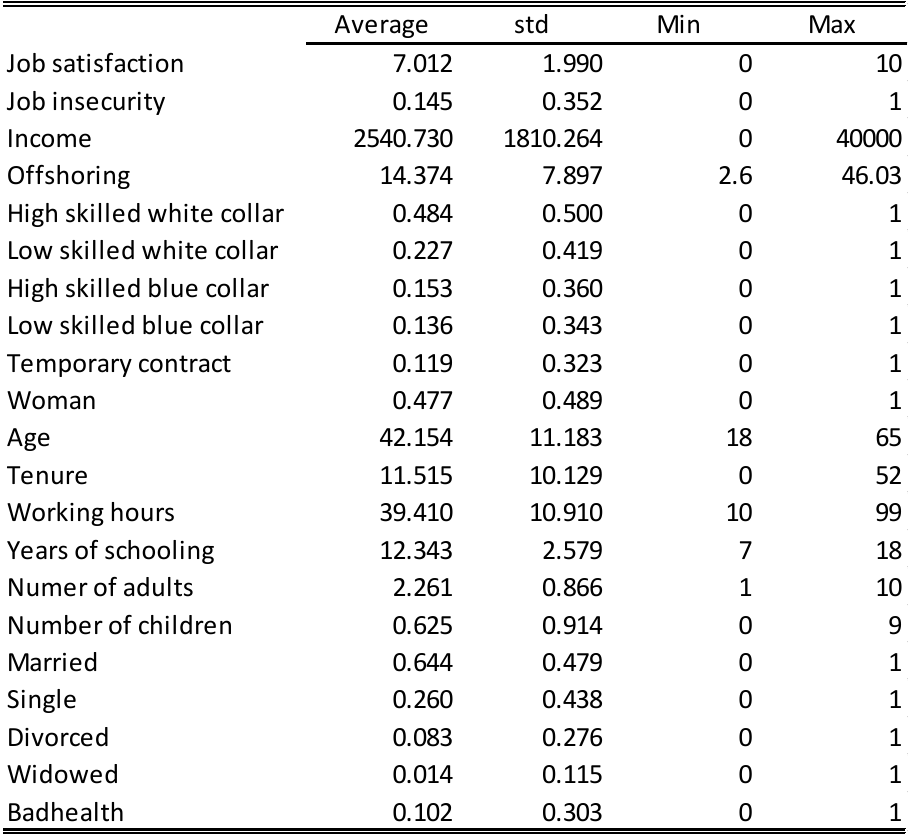
Table 1. Summary